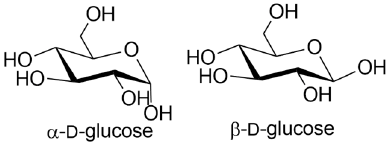
Figure 2. Structures of α‐ and β‐ D ‐ glucose.